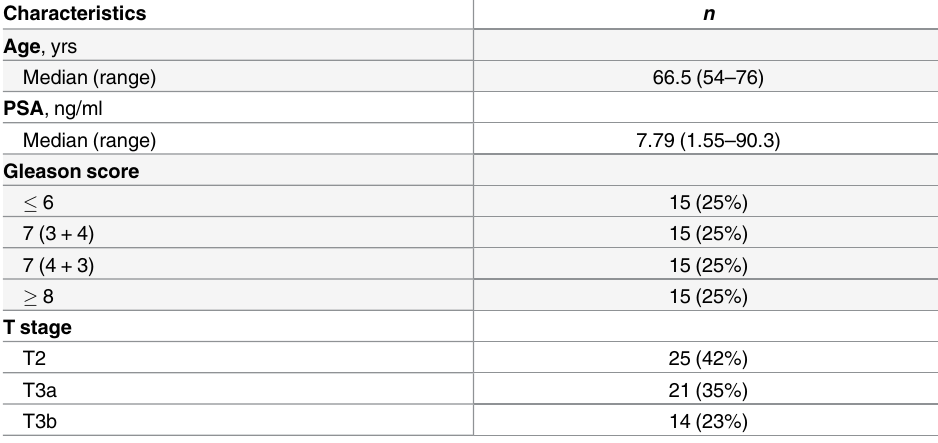
Table 1. Clinical Characteristics of Patients with